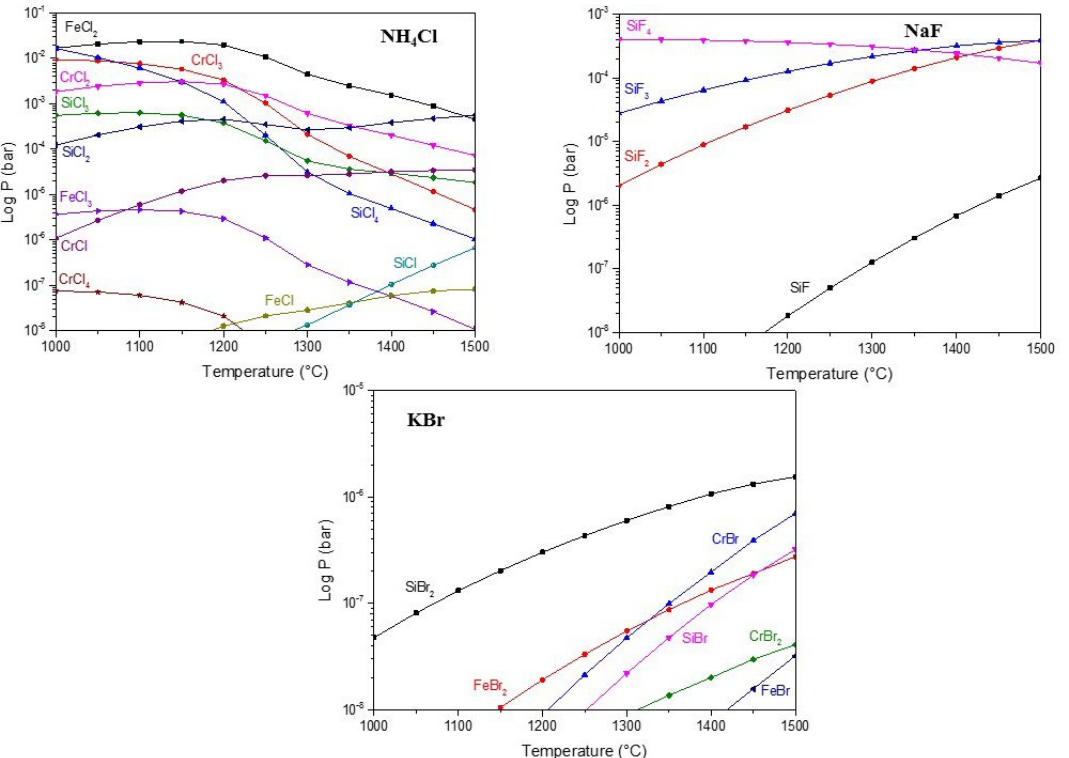
Figure 2. Equilibrium partial pressure of Fe, Cr and Si halide gaseous species involving the reaction of Fe-Cr-Si masteralloy with different activating